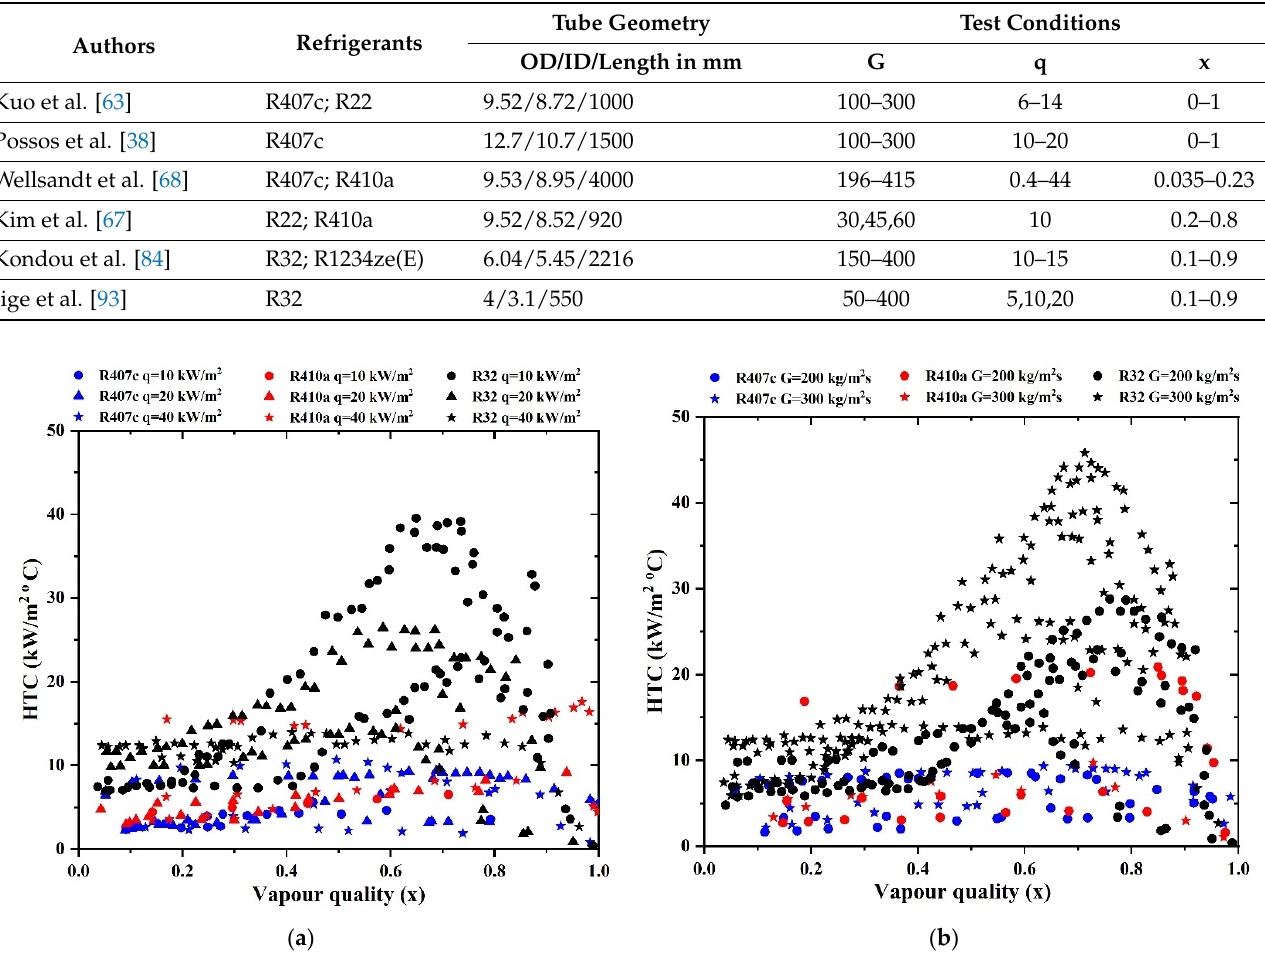
Figure 9. ( a ) Data comparison of R407c, R410a, and R32 on different heat flux, i.e., 10, 20, and 40 kW/m 2 ; ( b ) Data comparison of R407c, R410a and R32 on different mass flux, i.e., 200 and 300 kg/m 2 s. Table 5. Comparison of experimental conditions of different authors regarding results shown above for refrigerants R407c, R410a, and R32 in micro-finned tubes.